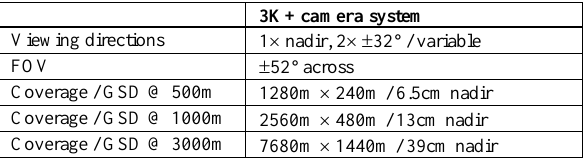
Table 2. Coverage and GSD of the 3K+ camera system